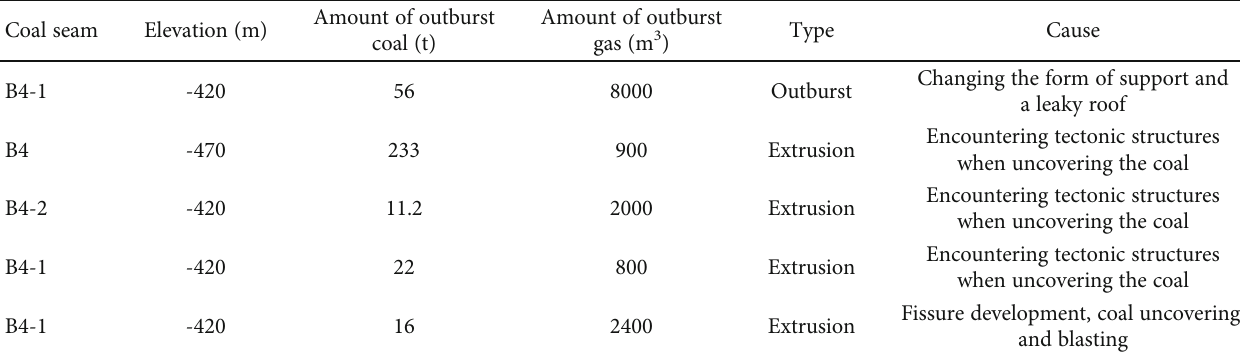
Table 1: Coal and gas outbursts during the construction of Paner Coal Mine. Coal